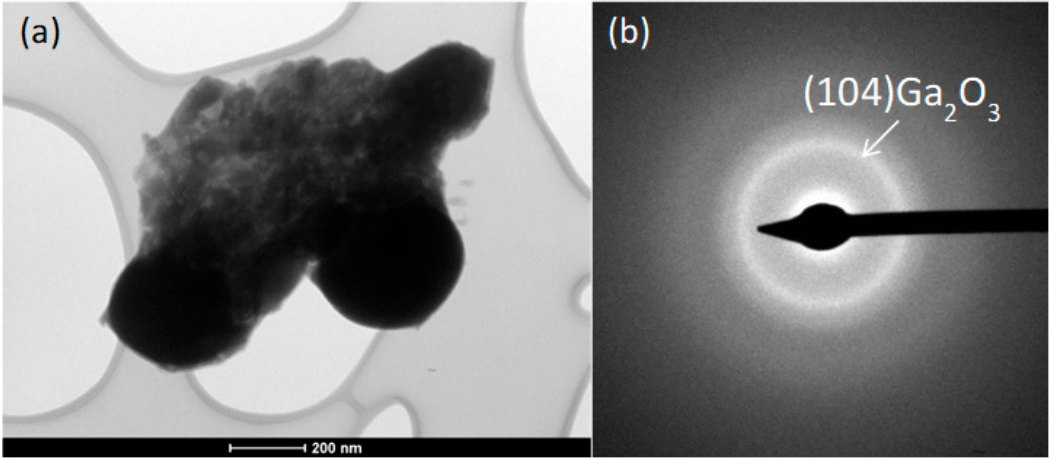
Figure 5. ( a ) TEM bright field image and ( b ) the corresponding selected area diffraction pattern.